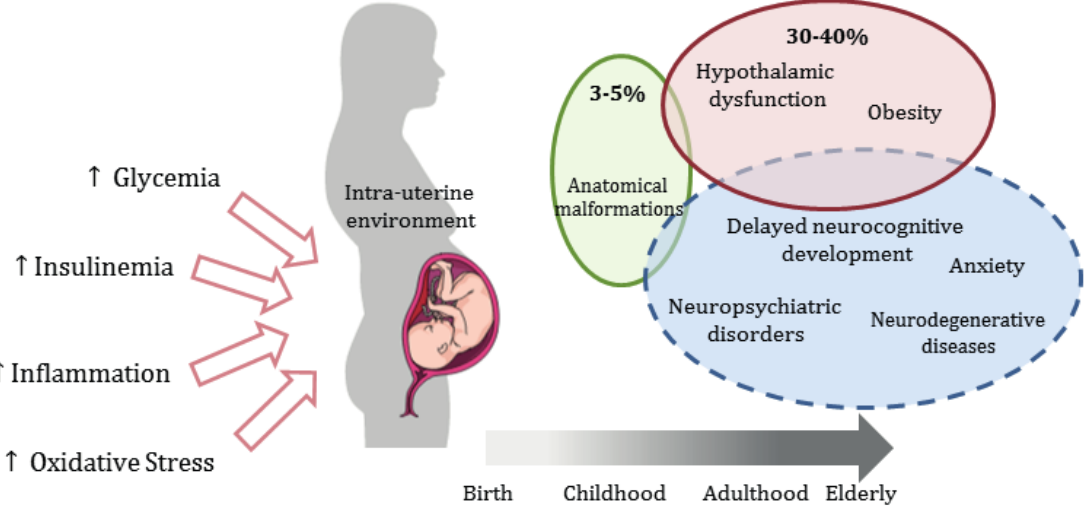
Figure 1 - Consequences of gestational diabetes (GD) to the offspring. Intra-uterine exposure to hyperglycemia, hyperinsulinemia, inflammation and oxidative stress, hallmarks of GD, is associated to anatomical malformations (green circle) and hypothalamic dysfunction/obesity (red circle) in the offspring. Emerging evidence suggest that GD might be associated to behavioral and neurophysiological defects in the offspring (dashed blue circle), which may only manifest at childhood, adulthood or old